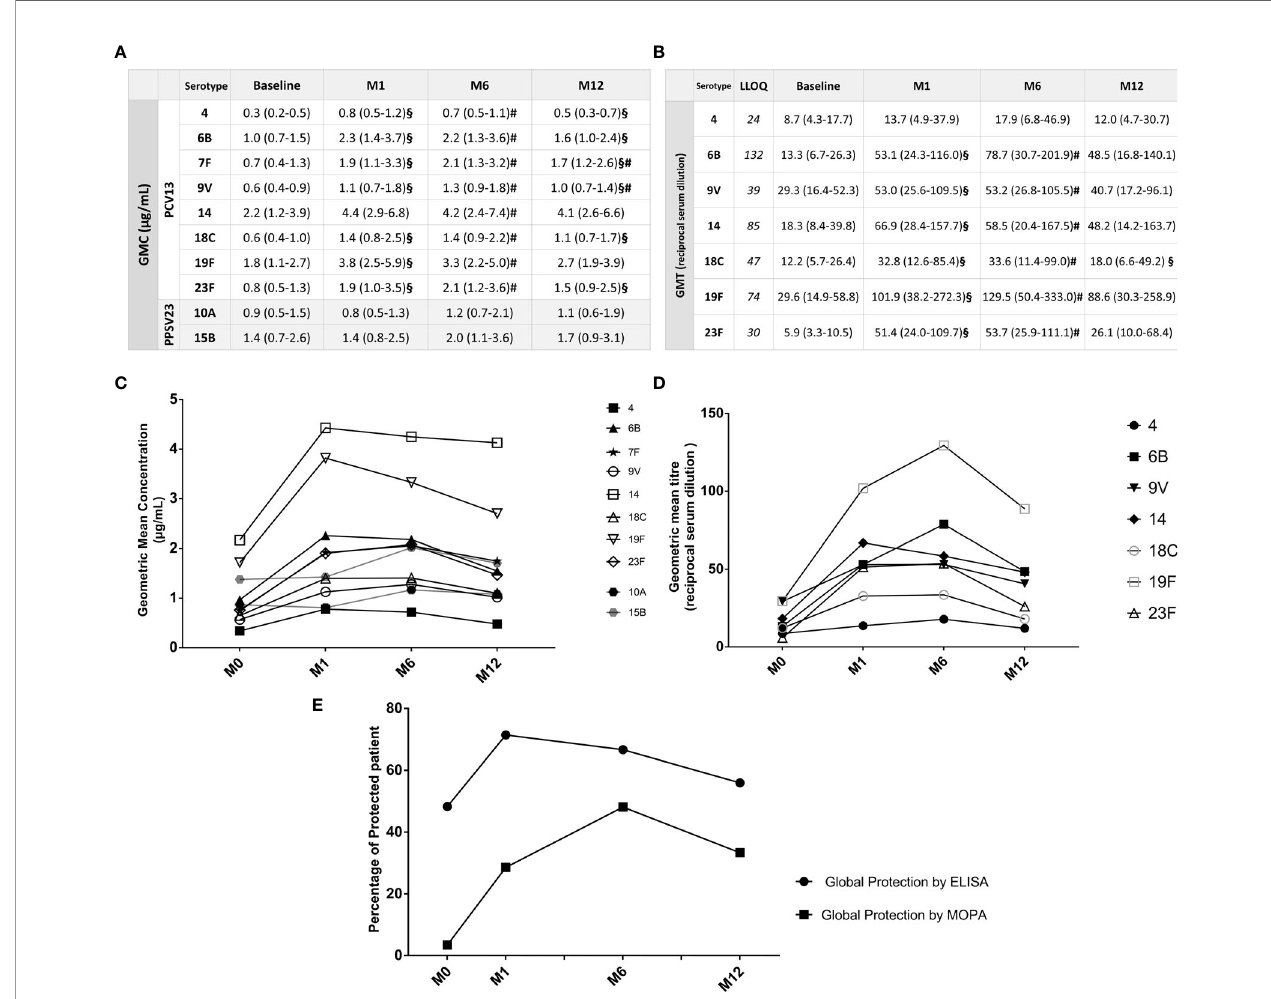
FIGURE 3 | Durability of protection based upon ELISA and MOPA analyses. (A) IgG seric GMC against each tested vaccinal serotype, at baseline, M1, M6 and M12: Data are in geometric mean concentrations (µg/mL) and its 95% con fi dence limits calculated from seric IgG concentrations (ELISA), for each tested serotype. § p < 0.05 when compared with previous concentration (Baseline/M1; M1/M6; M6/M12). # p < 0.05 when compared with baseline. The two serotypes 10A and 15B are not included in PCV13 vaccine and are represented here as controls. (B) Opsonization titers GMT against each tested vaccinal serotype, at baseline, M1, M6 and M12: Data are in geometric mean titers (GMT) (reciprocal serum dilution) and its 95% con fi dence limits calculated from OT (MOPA), for each tested serotype. § p < 0.05 when compared with previous concentration (Baseline/M1; M1/M6; M6/M12). # p < 0.05 when compared with baseline. (C) Evolution of IgG seric GMC through time: Representation of the evolution in time of the Geometric Mean Concentrations (GMC) of IgG (ELISA) for each tested serotype. The two serotypes 10A and 15B are not included in PCV13 vaccine and are represented here as controls. (D) Evolution of OT GMT through time: Representation of the evolution in time of the Geometric Mean Titers (GMT) of OT (MOPA) for each tested serotype. (E) Evolution of “ Global protection ” according to ELISA or MOPA analyses, through time: Percentage of “ globally protected ” patients among patients with complete data, based upon ELISA and MOPA analyses, at baseline and at one, six and twelve months after vaccination. Patients were considered as “ globally ” protected if IgG concentration was ≥ 1µg/mL for ≥ 5 of the serotypes according to ELISA analysis and if OT ≥ LLOQ for ≥ 5 of the serotypes based on MOPA